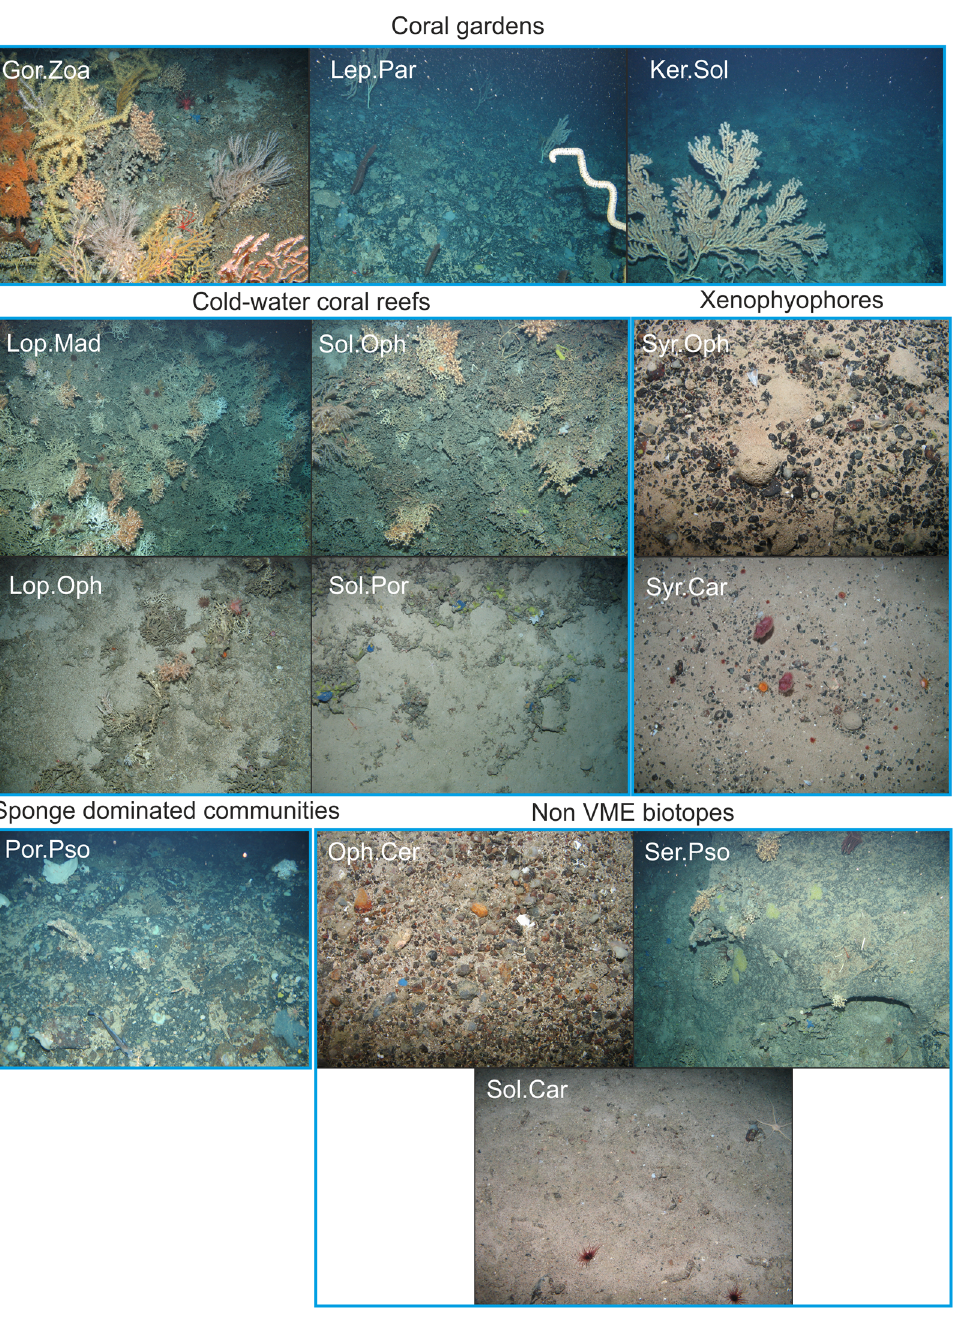
Fig 4. Example images of biotopes identified from multivarite cluster analysis. Refer to S1 Table for biotope details. g (Oph. Cer), i (Lop.Mad), j (Syr. Car), k (Syr.Oph), o (Por.Pso), p (Ser.Pso), t (Sol.Oph), u (Lop.Oph), w (Sol.Car), x (Sol.Por), y (Lep.Par), z (Ker.Sol), aa (Gor.Zoa). copyright JNCC, 2009.